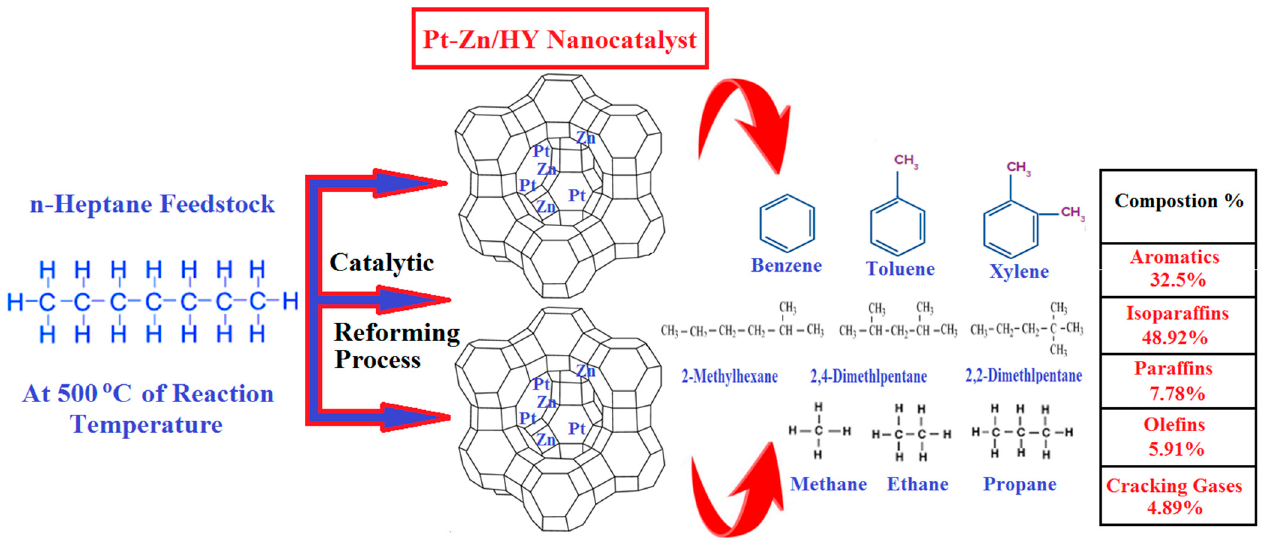
Figure 10. Schematic representation of the n-heptane reactions over the bimetallic Pt-Zn/HY nano-